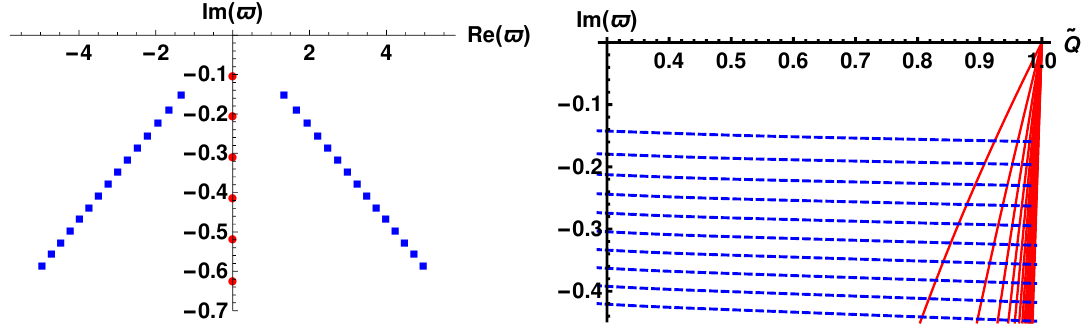
Figure 2 . Left: the QNMs of the CR background at e Q = 0 . 95 and X = − 0 . 47 . Right: the charge dependence of the imaginary parts of the QNMs at X = − 0 . 47 . The red filled circles/solid curves and blue boxes/dashed curves, are the imaginary near-horizon modes (set (iv)) and the complex CR modes (set (ii)), respectively.